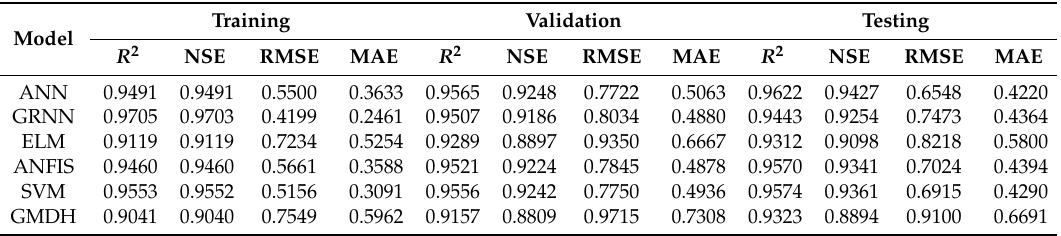
Table 2. Comparisons of data-driven models for gross primary productivity (GPP, g · C · m − 2 · Day − 1 ) for the training, validation and testing periods.